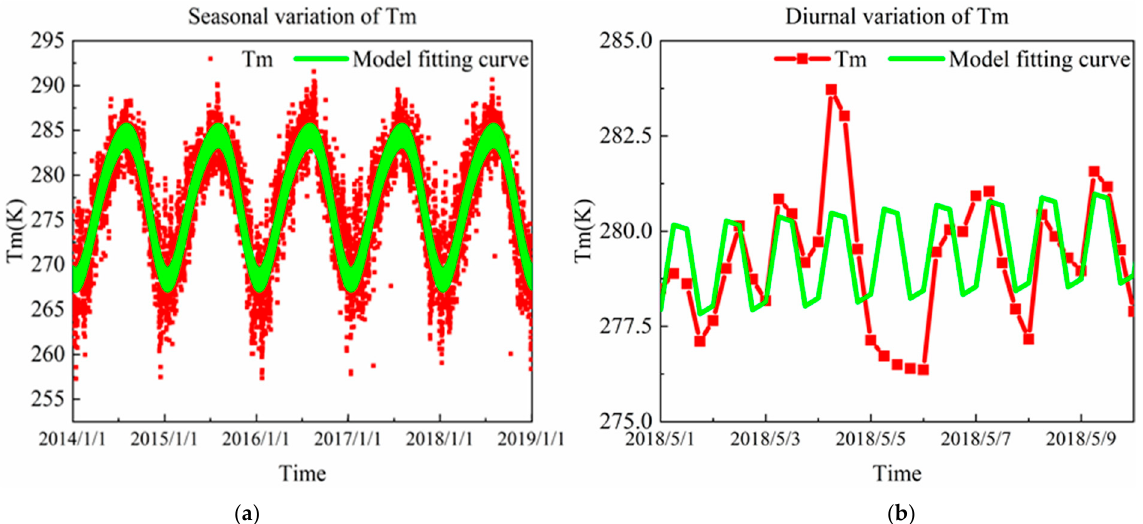
Figure 7. Seasonal ( a ) and diurnal ( b ) changes in the values estimated by the model.